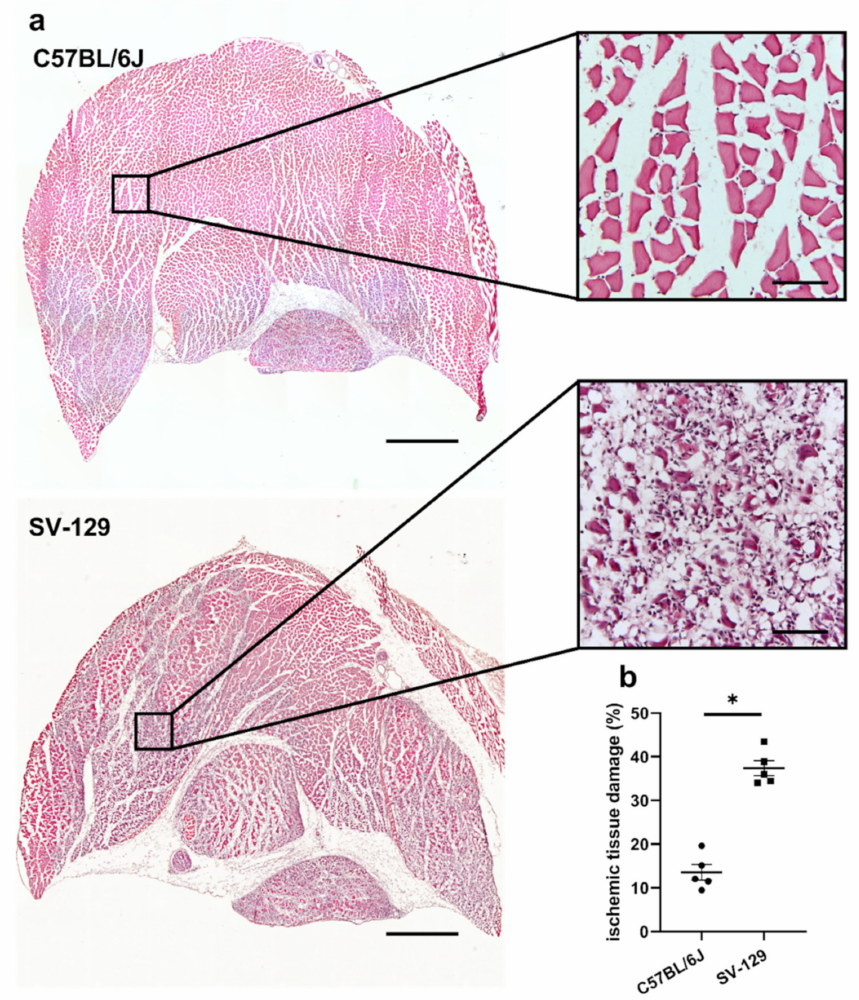
Figure 1. C57BL/6J mice show a smaller cross-sectional area of ischemic tissue damage in comparison to SV-129 mice. ( a ) Representative pictures of hematoxylin and eosin (H&E)-stained gastrocnemius muscles of C57BL/6J (top) and SV-129 mice (bottom) collected 7 days after femoral artery ligation (FAL). Skeletal muscle cells that show centralized nuclei are a sign of regenerating muscle cells and hence ischemic damage. Scale bars: 1000 µ m (overview), 100 µ m (detail). ( b ) The scatter plot displays the relative area of ischemic tissue damage (%) in gastrocnemius muscles of C57BL/6J and SV-129 mice isolated 7 days after FAL. One complete sectional area was analyzed per mouse per